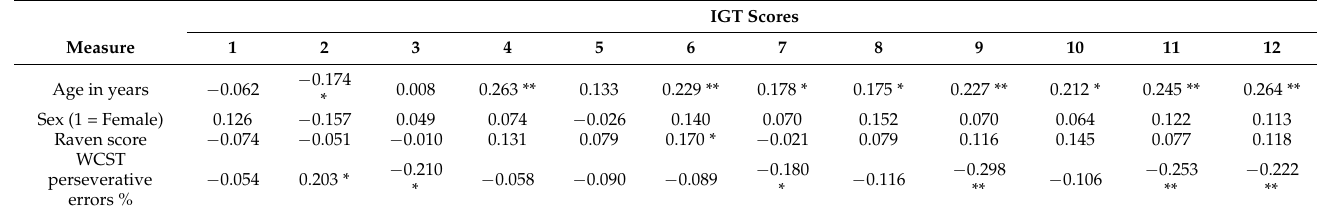
Table 2. Correlation analyses between cognitive tasks and IGT measures. IGT Scores